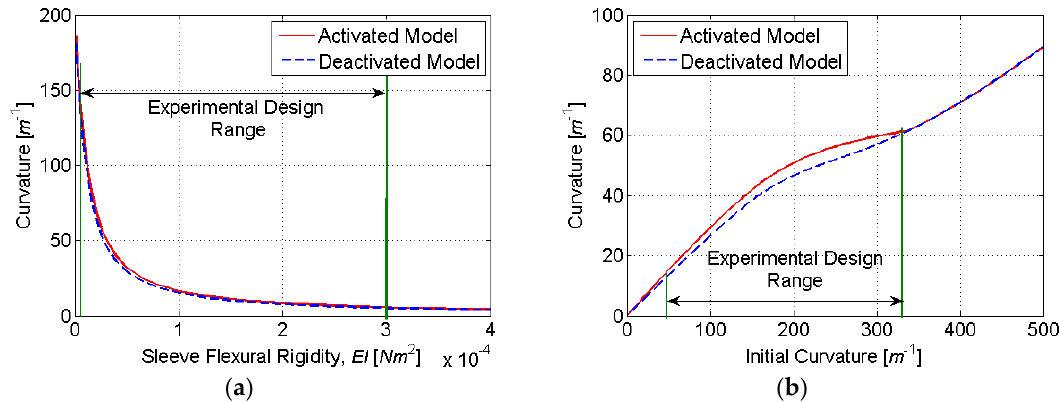
κ . Figure 10. Simulation results used to determine the parametric range of ( a ) EI and ( b ) κ 0 0